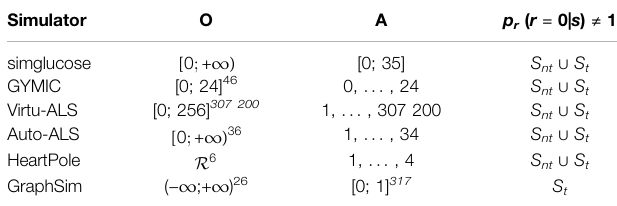
TABLE 3 | Summary of each simulator: POMDP